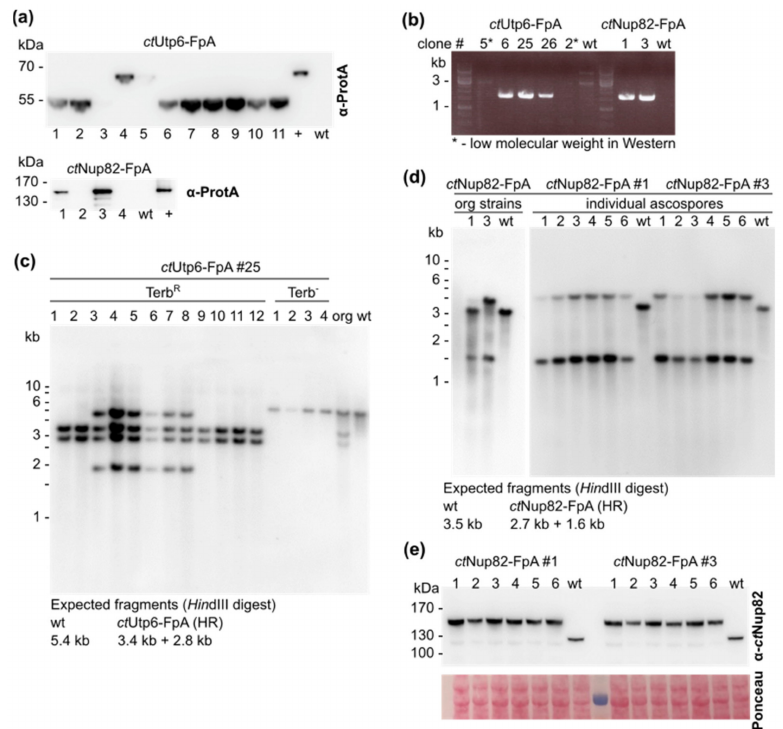
Figure 2. Verification of HR-mediated gene replacement events. ( a ) Representative Western analysis of individual Terb R transformants showing expression of FpA-tagged Utp6- (upper panel) and Nup82- fusion proteins (lower panel) integrated in locus in ∆ ligD#56.2. Expression was revealed with α -Protein A antibodies on whole cell protein lysates. Wild-type C. thermophilum protein lysate was included as negative control; the respective strain derived upon ectopic chromosomal integration of the respective fusion protein served as positive control. A molecular weight standard with molecular weights (kDa) is depicted on the left. ( b ) PCR analysis performed on gDNA isolated from Terb R mycelia previously tested positive via Western analysis to verify in locus gene-replacement events. A marker-specific oligonucleotide and an oligonucleotide designed to anneal outside the homologous region were used and only those clones that underwent a correct recombination event would produce an amplicon of the designated size. For Utp6-FpA clones showing lower molecular weight bands in the Western blot, no amplicon could be produced, indicating unspecific recombination events. ( c ) Southern analysis confirming HR- mediated gene replacement in the utp6 locus. Mycelia from 12 Terb R and four Terb − ascospores were harvested and subjected to gDNA isolation and digestion with restriction endonucleases. gDNA from one positively tested original strain ∆ ligD Utp6-FpA #25 as well as wild-type gDNA was included as control. A combination of left and right homologous flanking regions was used as probe, and the expected fragments upon Hin dIII digestion are shown below, indicating segregation of the different alleles upon formation of sexual ascospores. ( d ) Southern analysis confirming the segregation of wild-type- and HR-mediated gene fusion alleles of ∆ ligD Nup82-FpA #1 and #3 upon the generation of sexual ascospores. Hin dIII-digested gDNA of the original strains is indicated on the left, gDNA isolated from mycelia of six individual ascospores is shown on the right. Wild-type gDNA is included as control. A combination of left and right homologous flanking regions was used as probe and the expected fragments for the wild-type and the strains undergoing homologous recombination events are indicated below (the calculated fragments for the HR allele differ from the actually observed fragments, possibly due to erroneous genome annotation.) ( e ) Western analysis of mycelia resulting from individual ascospores of ∆ ligD Nup82-FpA to verify HR- derived gene replacements leading to isogenic strains and expression of the respective fusion proteins. Expression was revealed with α - ct Nup82 antibodies on whole cell protein lysates and wild-type protein lysate was included as control. Equal loading was confirmed by Ponceau S staining. A molecular weight standard with molecular weights (kDa) is depicted on the